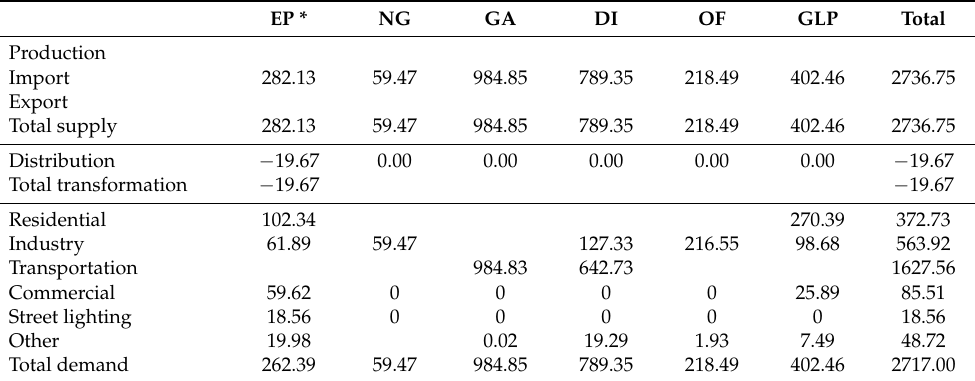
Table 3. The energy balance of the city of Cuenca Canton (kBOE).